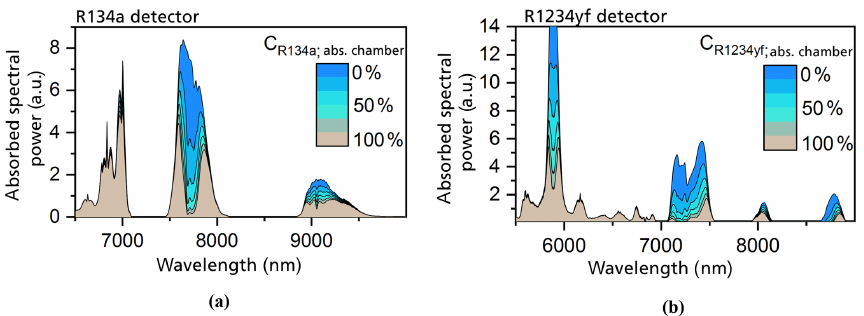
Figure 4. The simulated absorbed spectral power densities in the detection chambers with different concentrations of R134a (a) and R1234yf (b) in the respective detectors (Weber et al., 2019). The absorption chamber length is set to an optimal value of 4mm for the R134a detector and 1mm for the R1234yf detector. The detection chamber was set to a length of 3mm and a diameter of 8mm in both cases, whereas the gas-filled filter chamber length was set to